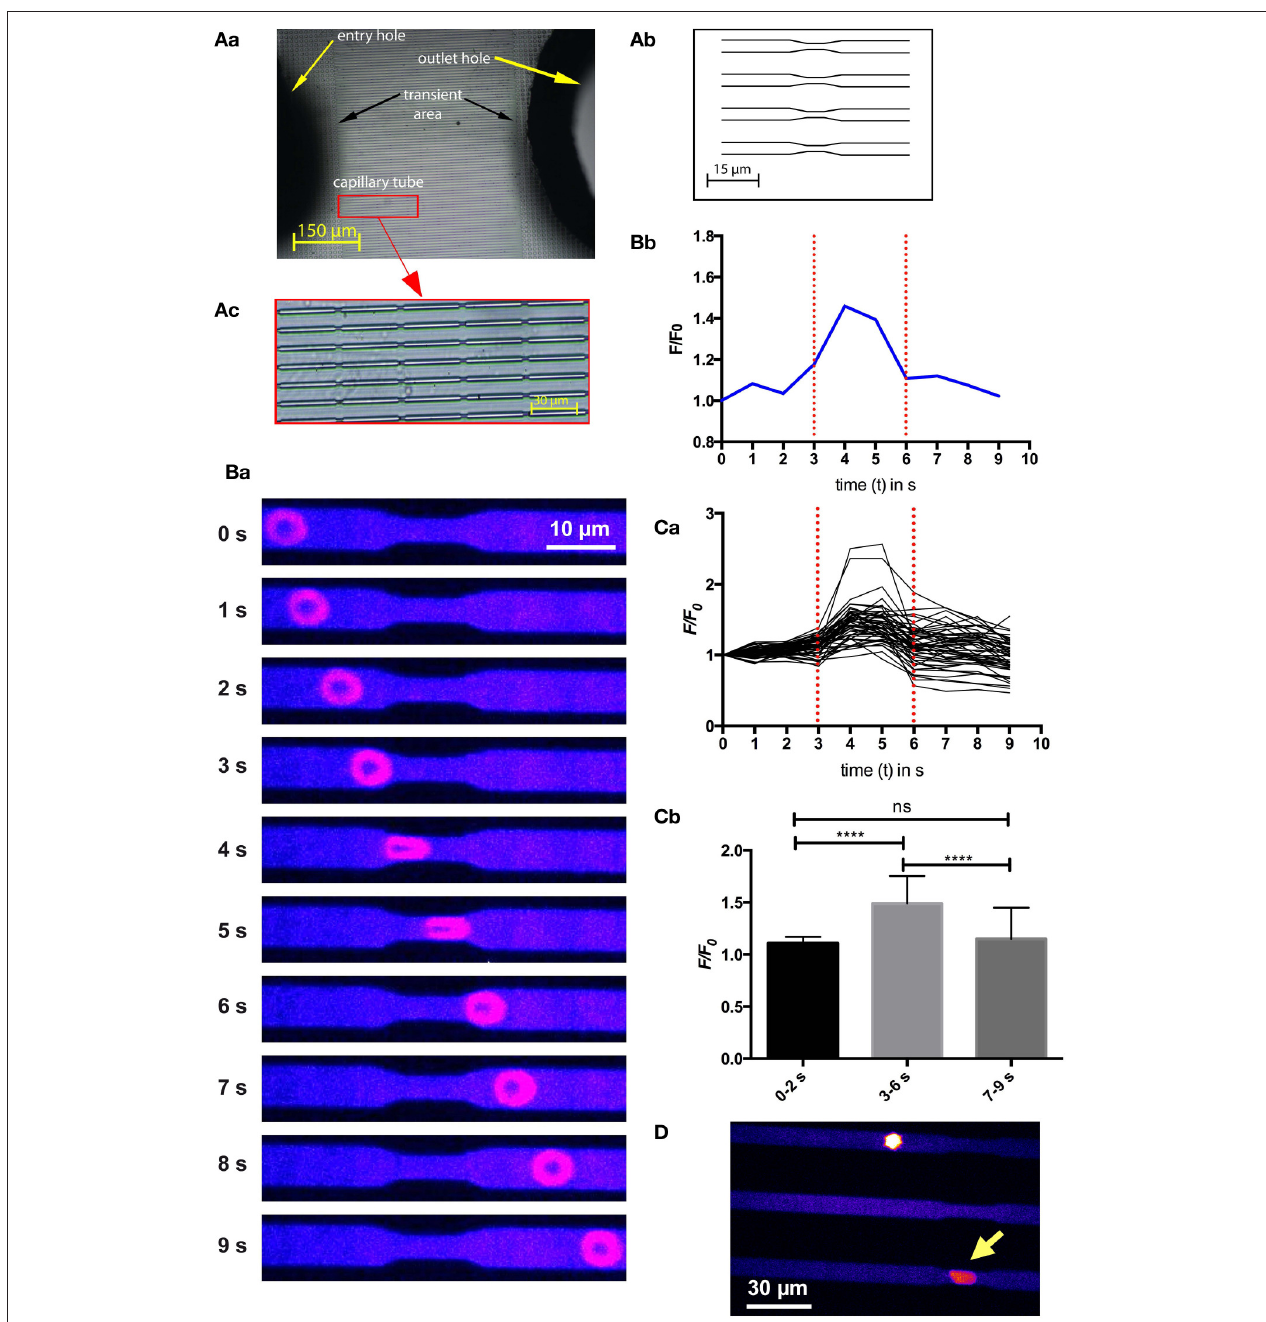
FIGURE 3 | Ca 2 + -signaling of a RBC passing through constrictions in a microfluidic chip. (A) depicts the design of the microfluidic chip used. A photographic overview with labeled parts of the chip is given in (Aa) , whereas a schematic overview of parallel channels with constrictions to simulate capillaries is drawn in (Ab) . In contrast, the real appearance of the channels with repetitive constrictions is displayed in (Ac) . (B) exemplifies a typical experiment. Fluorescent confocal images of a Fluo-4 loaded cell when passing through the microfluidic channel at 10 time points are shown in (Ba) . The color scale is the same as in Figure 1Aa . The fluorescence intensity (F/F 0 ) of the RBC at the 10 time points shown in (Ba) is plotted in (Bb) indicating the start and the end of the constriction by red dotted lines. A video of this experiment is available in the supplemental material (Supplemental Video 1). (C) depicts the analysis of 52 cells measured while passing through the constriction. The fluorescence intensity (F/F 0 ) traces of all measured RBCs are plotted in (Ca) . The statistical analysis of the maximal fluorescence intensity (F/F 0 ) at time points before the constriction (0–2s), when passing through the constriction (3–6s) and after passing through the constriction (7–9s) is depicted in (Cb) . The increase in Ca 2 + , while passing through the constriction is highly significant ( p < 0.0001; ****). (D) Shows an image of RBCs treated with 1 µ M GsMTx-4 getting stuck in the microfluidic channels. The yellow arrow points to a cell sticking in a constriction. To better judge the resting state of the cell please refer to Supplemental Video 2.